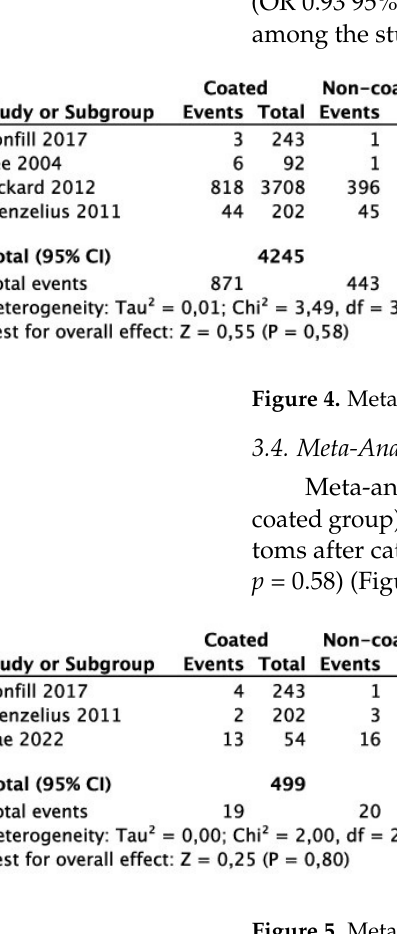
Figure 5. Meta-analysis of the number of patients reporting lower urinary tract symptoms at follow- up after removal of catheter.